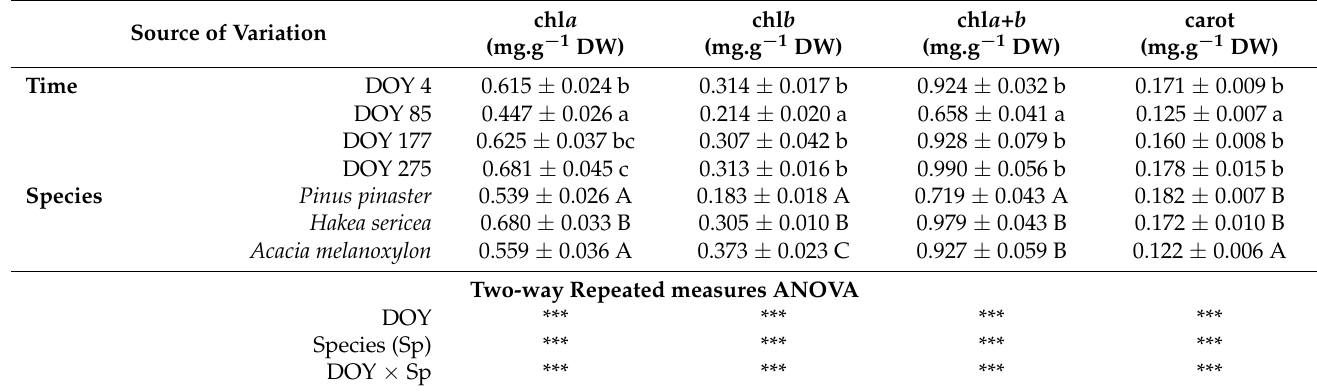
Table 1. Concentration of photosynthetic pigments (chl a , chl b , chl a + b , and carrot) from leaves of Pinus pinaster , Hakea sericea and Acacia melanoxylon during 2019. Following two-way repeated measures ANOVA, for each trait, different lowercase letters indicate significant differences ( p < 0.05) among day of the year (DOY) and different capital letters represent significant differences among species according to the Tukey’s HSD test results. *** p <